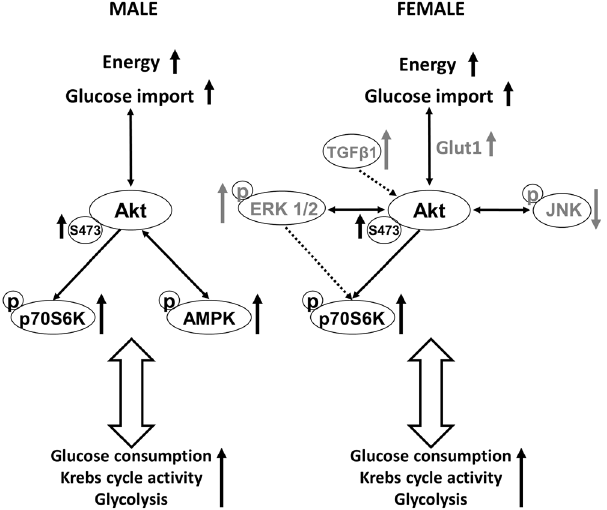
Figure 6. Summary of changes in cell signaling pathways in mouse kidneys as a result of CypD ablation. Increased expressions of phospho-AKT S473 and phospho-p70S6K and pAMPK (in males only) were observed in Ppif − / − mice. Additionally, Ppif − / − females (presented on the right side of the image) showed a reduced expression of TGF β 1 as well as higher expression of phosphorylated ERK1/2 and p38 proteins. ↑ : increase compared to WT controls, ↓ : decrease compared to WT controls. Please note that a direct link between the phosphorylation of Akt and phosphorylation of MAP kinases p38 and ERK1/2 is not fully confirmed in the here used mouse model. Please also note that, since our experiments were performed in the whole kidney, the exact contribution of each subcellular fraction to the observed changes requires further